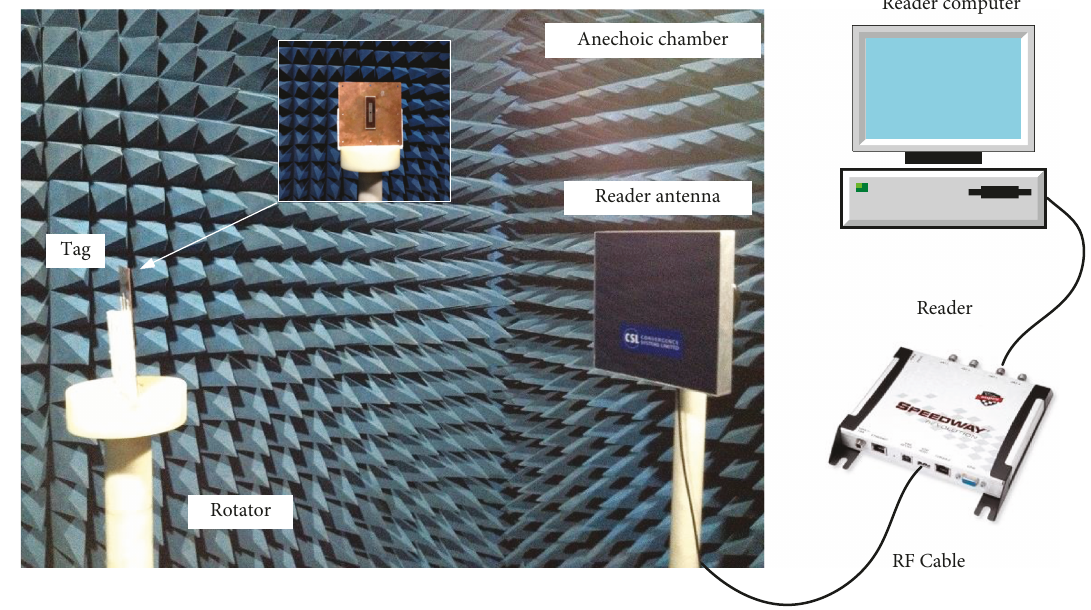
Figure 8: The back-scattering measurement setup.